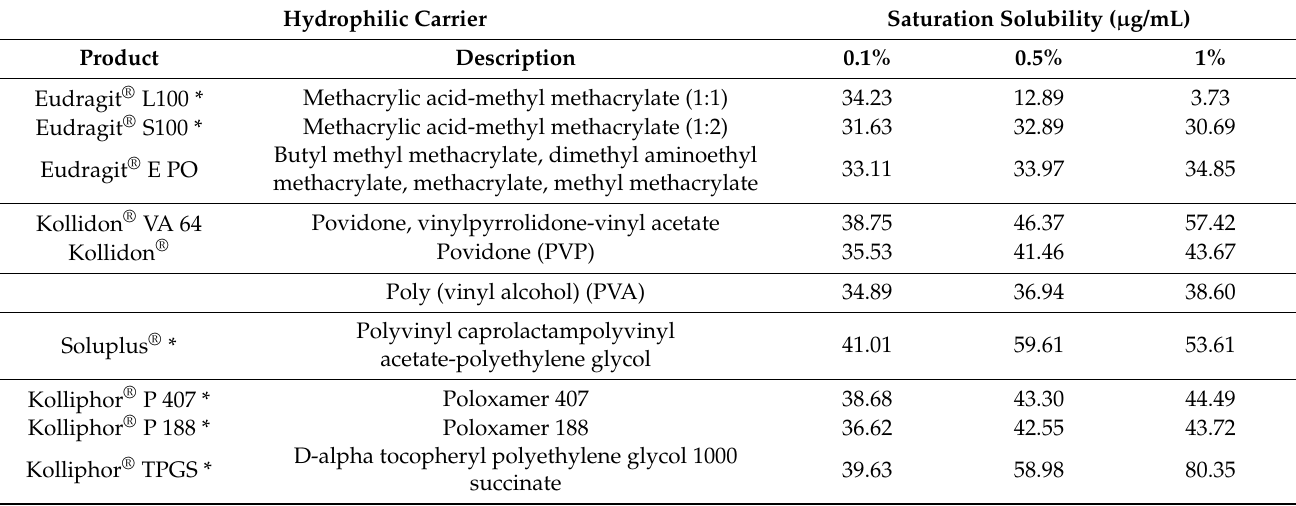
Table 3. Saturation solubility of APX in water with different hydrophilic carriers at 0.1%, 0.5% and 1%.